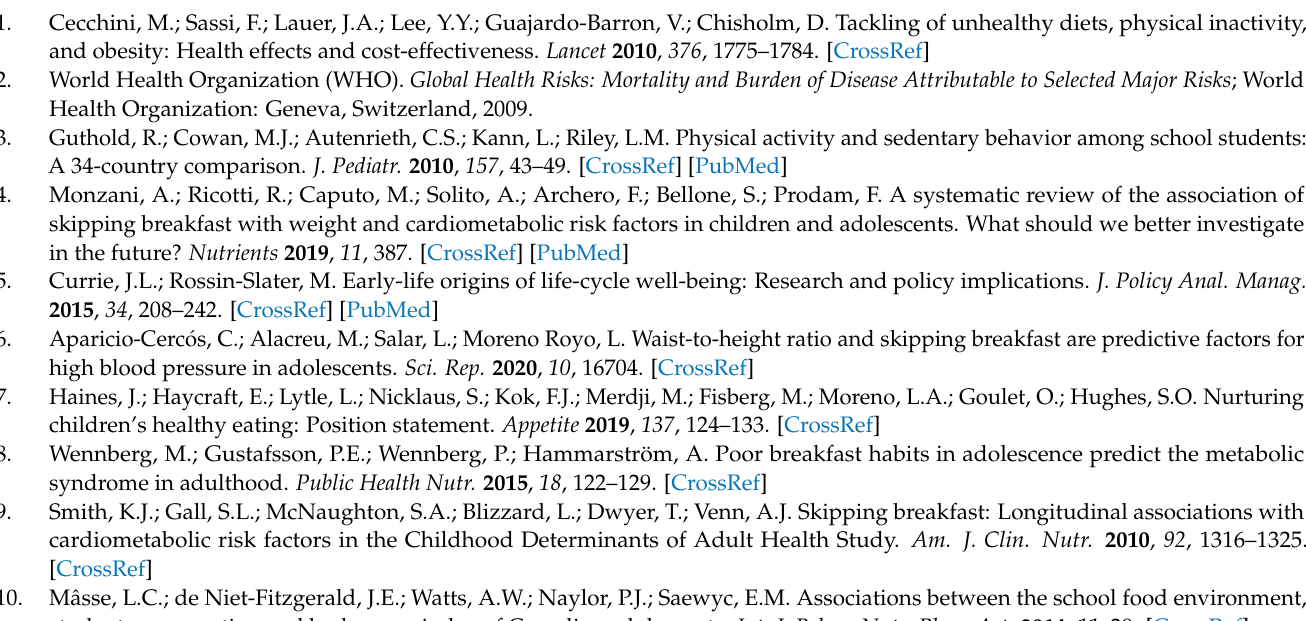
study; Table S2.1. Factor loadings of main identified dietary and PA patterns (boys); Table S2.2. Factor loadings of main identified dietary and PA patterns (girls); Table S2.3. Factor loadings of main identified dietary and PA patterns (Moscow); Table S2.4. Factor loadings of main identified dietary and PA patterns (Murmansk); Table S2.5. Factor loadings of main identified dietary and PA patterns (10–12 y/o); Table S2.6. Factor loadings of main identified dietary and PA patterns (13–15 y/o); Table S2.7. Factor loadings of main identified dietary and PA patterns (16–17 y/o); Table S3: Associations in strata by sex, age, place of